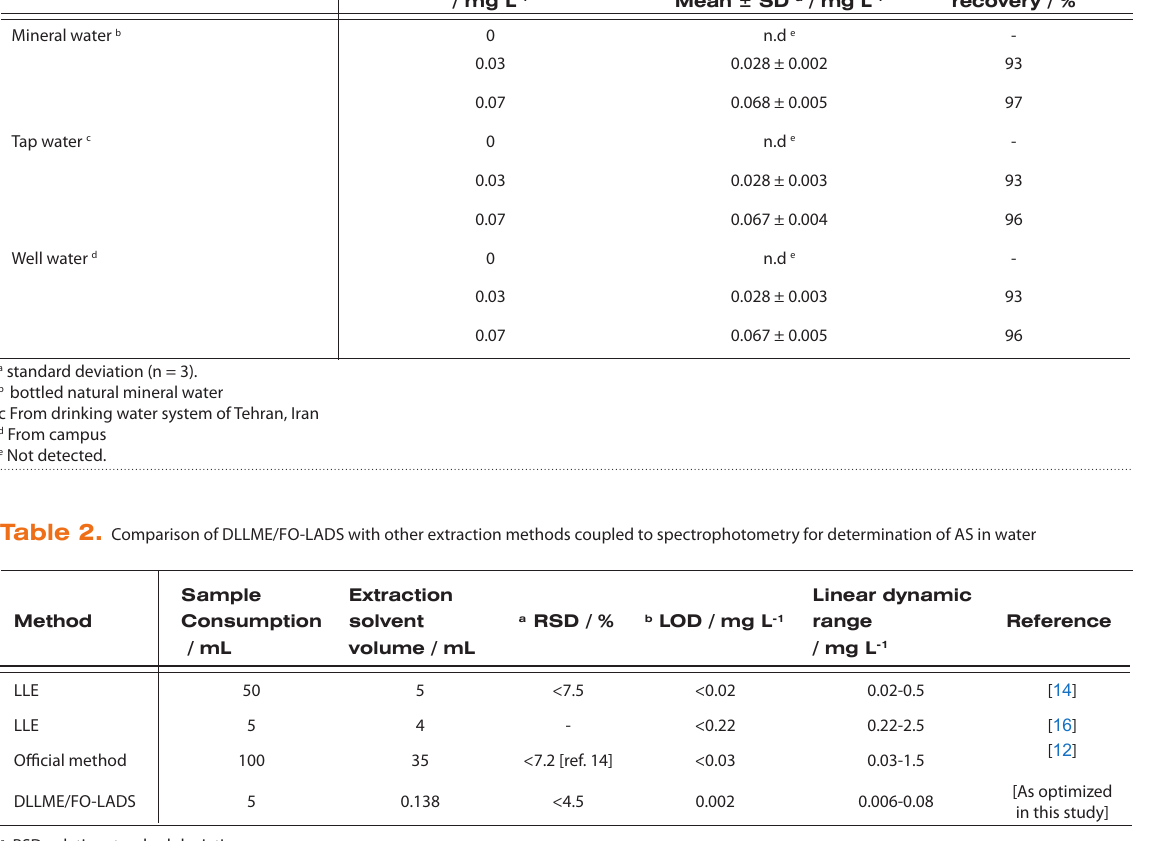
Table 1. Determination of AS in mineral, tap, and well water samples, and relative recovery of spiked AS in these